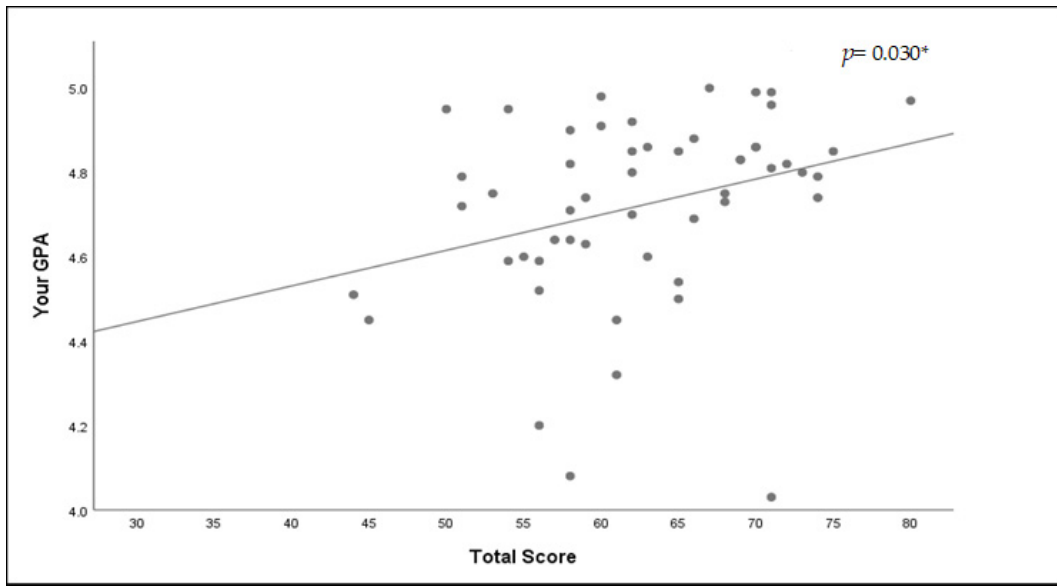
Figure 3. Correlation between the number of errors students detected and their system thinking score with correlation coefficient and p -value.